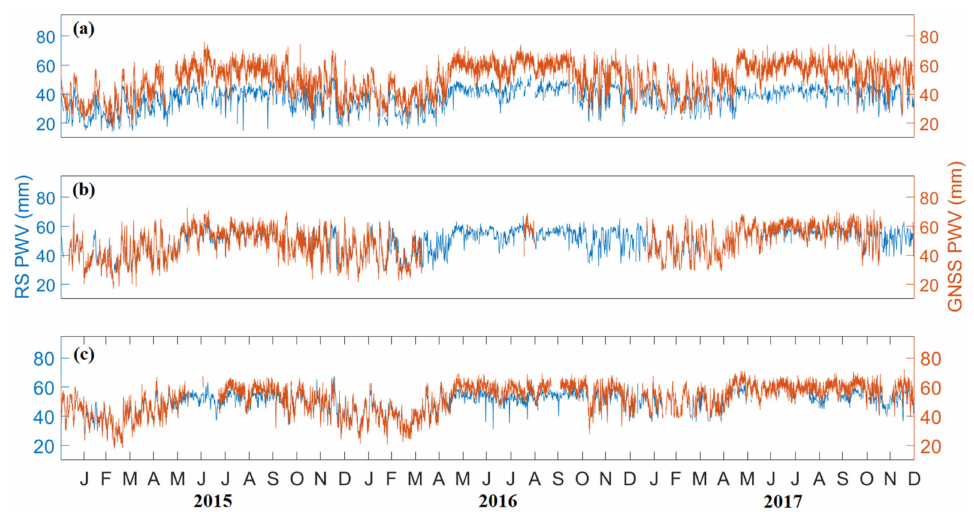
Figure 3. The time series of RS PWV (blue) and GNSS PWV (orange) in ( a ) Tanay and PIMO, ( b ) Legaspi and PLEG, and ( c ) Puerto Princesa and PPPC from 2015 to 2017.